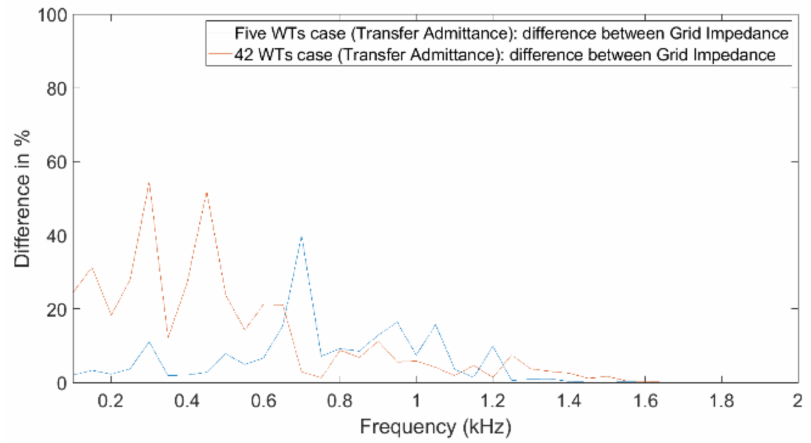
Figure 23. Difference (%) due to public grid impedance: transfer admittance (A/V) from all turbines to one turbine (T1) in 5- and 42-turbine cases.